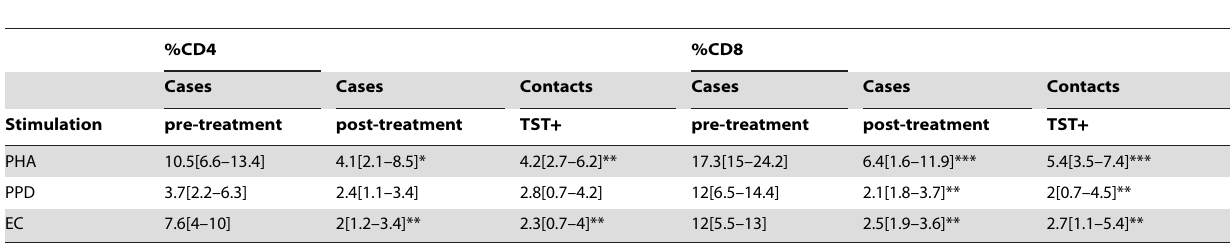
Table 1. Proportion of CD4 + or CD8 + cells positive for any of the 4 factors (CD107a, IFN- c , IL-2 or TNF- a ) following overnight antigenic